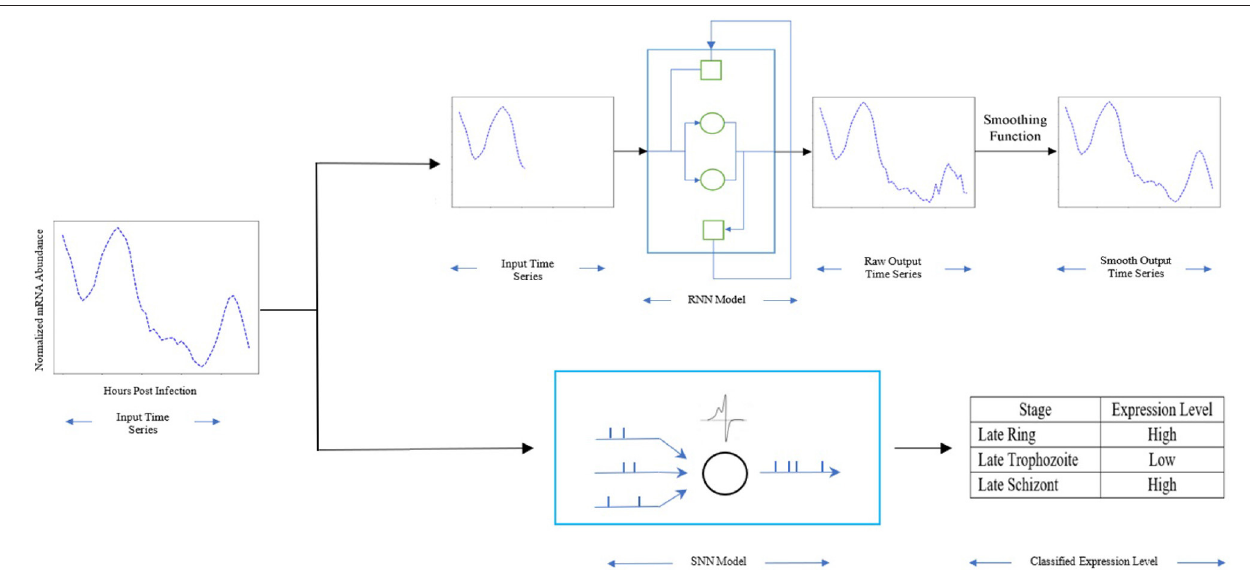
FIGURE 1 | The method overview: Light blue rectangle represents our RNN model with the gated units as cycles, the hidden units as squares, the dark blue rectangle represents our SNN model with the spiking neuron as cycles. The input is the mRNA abundance time series of PF3D7_1337500. The early stage time series is used for RNN, the whole time series is used for SNN. The output of RNN is the mRNA abundance time series during its life cycle in blood stage, the output of SNN is the expression level for multiple